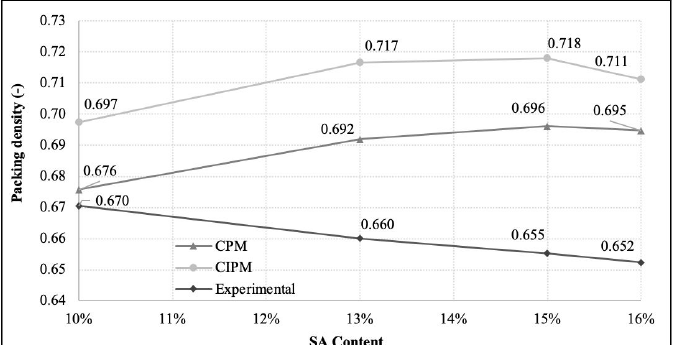
Figure 9. Packing densities of the PC, SP and SF combinations using the CPM 34 and CIPM 18,35 models and the experimental method 33